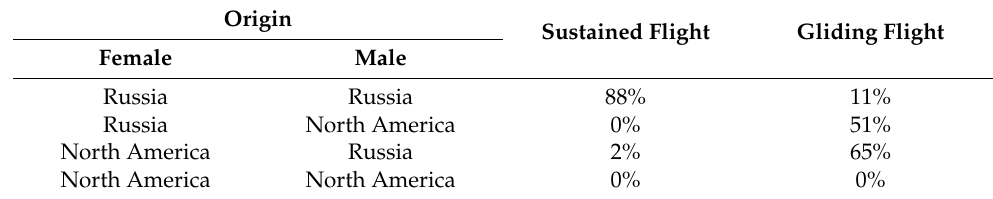
Table 1. Origin and flight-capacity percentages of North American, Russian, and hybrid gypsy moths